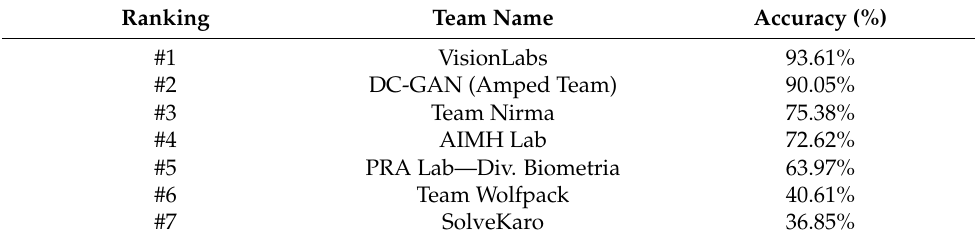
Table 2. Ranking of Task I. The classification accuracy value is reported (in percentage %) for each